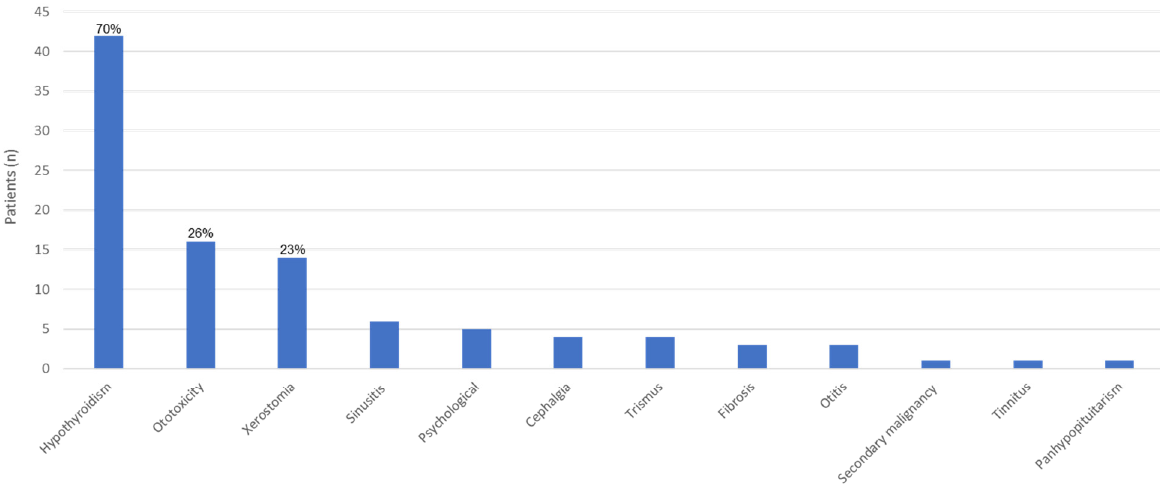
Figure 3. Distribution of late effects in 60 patients of the NPC-2003 study and interim